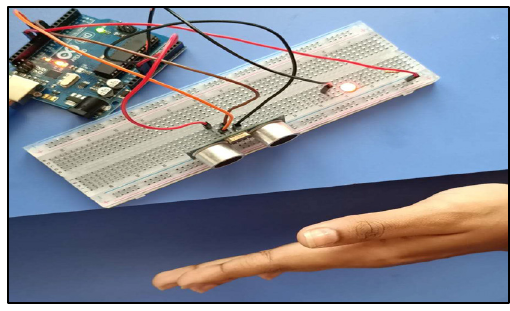
Fig. 6. Ultrasonic Sensor Reaction 1